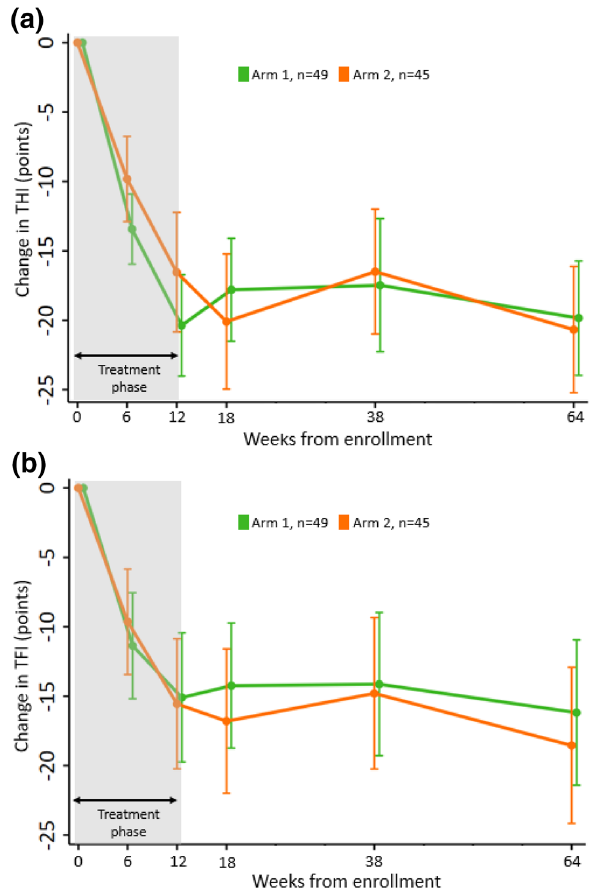
Figure 4. Long-term clinical efficacy of bimodal neuromodulation. Change in THI score ( a ) or TFI score ( b ) from baseline to the different time points are plotted up to the 12-month post-treatment visit (Week 64) for participants who were treatment-compliant (≥ 18 h treatment at interim and ≥ 36 h treatment at final) and attended all visits. Mean change values and 95% CIs are plotted for each arm. All data points with CIs are substantially below the zero line, supporting that bimodal neuromodulation with sound and tongue stimulation achieves significant reduction in tinnitus symptoms that is sustained for 12 months after treatment ended. For clearer visualization, data points and error bars were jittered in